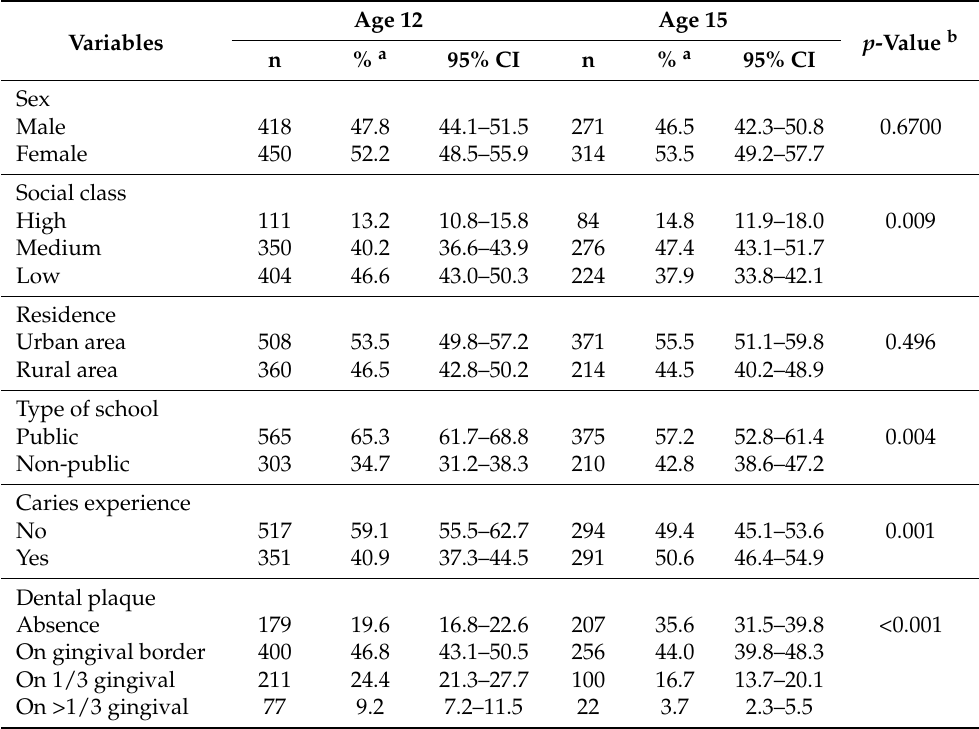
Table 1. Distribution of socio-demographic and oral health variables in the samples of 12- and